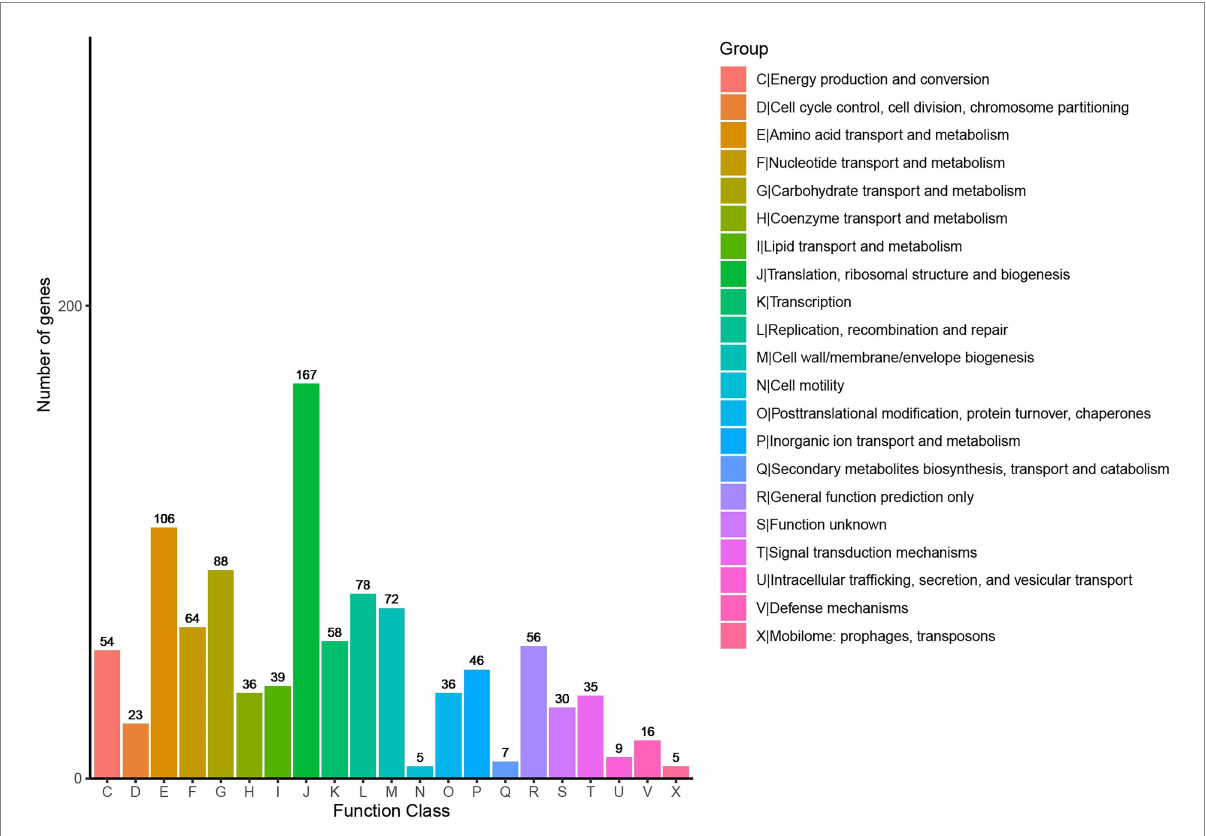
FIGURE 2 Distribution of genes across COG functional categories in the genome of L. salivarius S01.